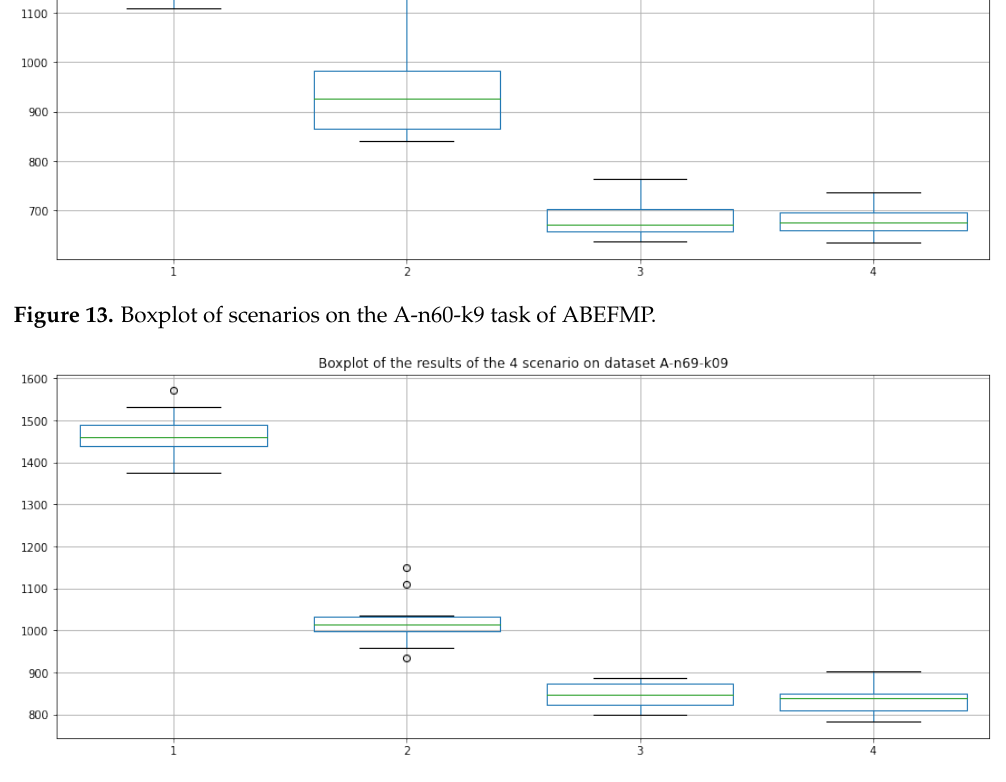
Figure 14. Boxplot of scenarios on the A-n69-k9 task of